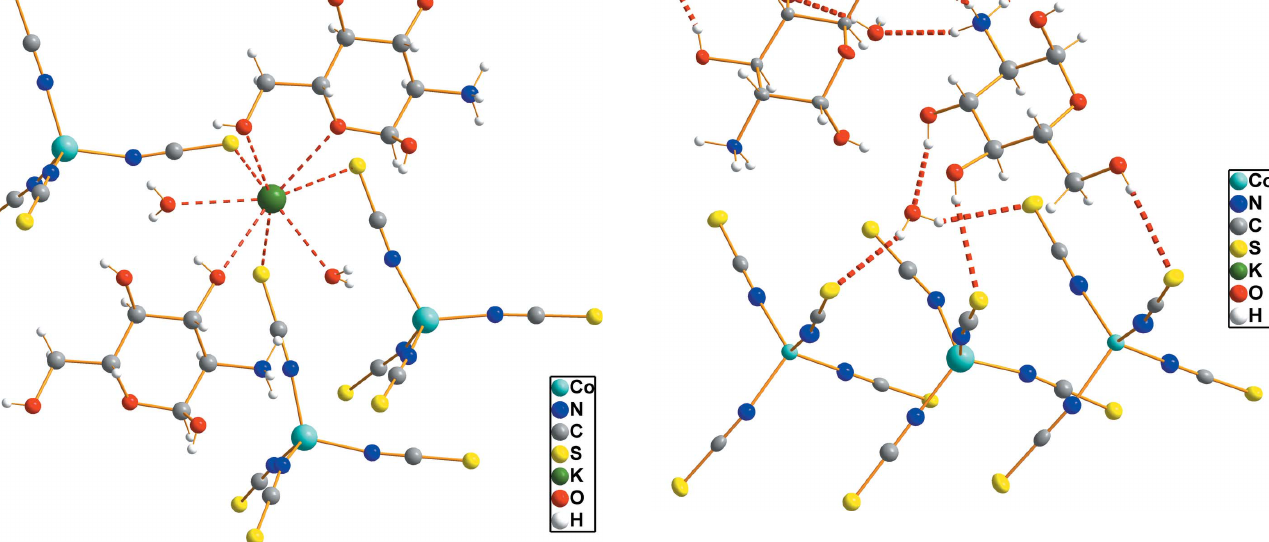
Figure 2 View of the coordination environment of the potassium cation in (GlcNH)(K)[Co(NCS) 4 ] (cid:2) 2H 2 O.